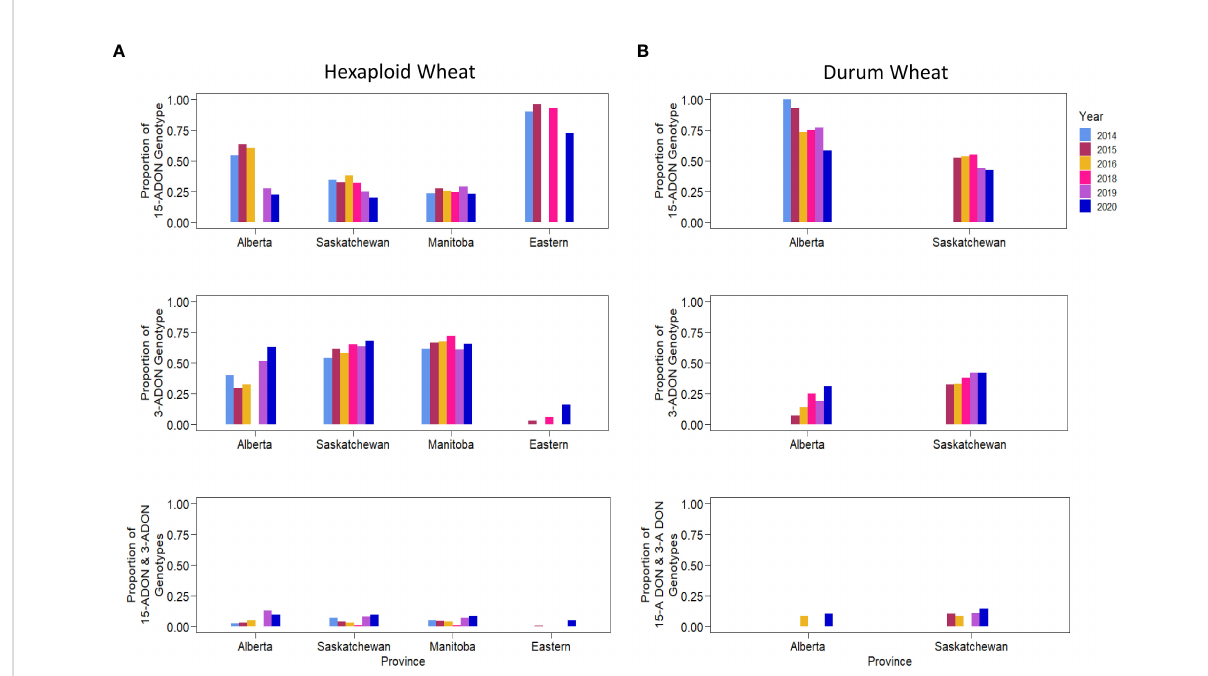
FIGURE 6 The proportion of different trichothecene genotypes present in wheat kernels across years. The proportion of kernels testing positive for 15- ADON (top), 3-ADON (middle), or both (bottom) for (A) hexaploid wheat, and (B) durum